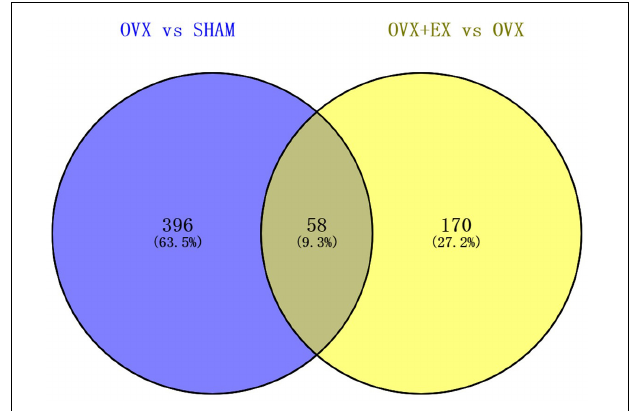
FIGURE 3 | Venn diagram representing the overlap of DEGS in OVX vs. SHAM and OVX + EX vs.